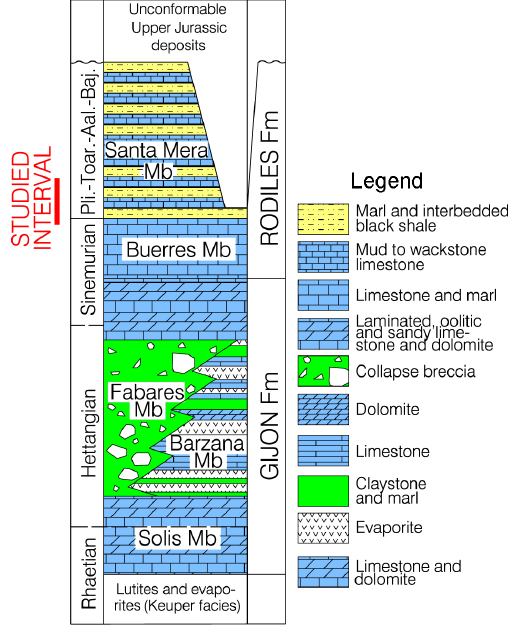
Figure 2. Sketch of the stratigraphical succession of the uppermost Triassic and the Jurassic deposits of the Asturian Basin. The studied interval corresponds to the lower part of the Santa Mera Member of the Rodiles Formation. Pli. = Pliensbachian, Toar. = Toarcian. Aal. = Aalenian. Baj. =